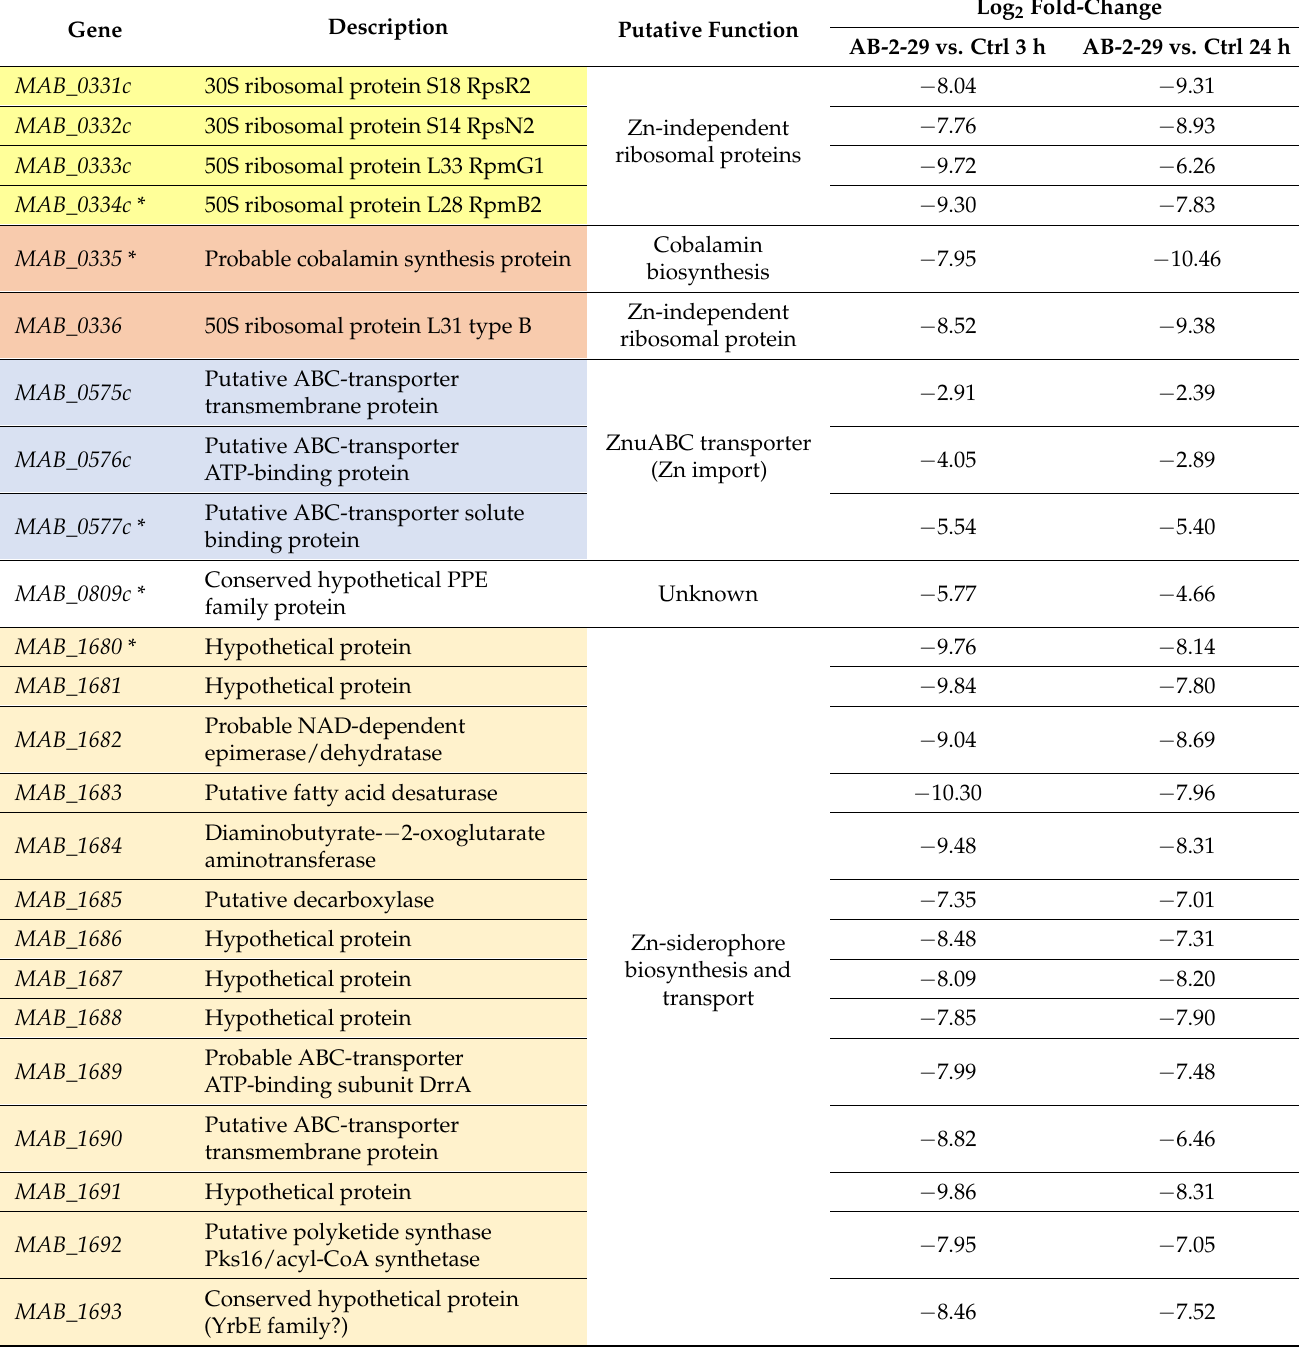
Table 2. List of Zur regulon genes that were expressed at higher or lower levels upon treatment with AB-2-29 compared to DMSO control . Differentially expressed genes upon treatment with 20 µ M AB-2-29 for 3 or 24 h were defined as ≥ 2 log 2 fold-change in expression compared to cells treated with 0.2% DMSO for the same amount of time, with a false discovery rate adjusted p -value (padj) < 0.05. Genes harboring a zur-box in their promoter (see Figure 2B) are marked with an asterisk. Similarly colored genes denote gene clusters likely to be cotranscribed. MAB_0331c, MAB_0332c, MAB_0333c, MAB_0334c and MAB_0336 are Zn-independent alternative ribosomal proteins. MAB_0335 is likely to be involved in cobalamin biosynthesis. MAB_0575c-MAB_0576c- MAB_0577c encode a putative zinc importer of the ABC-transporter family. The operon encompassing genes MAB_1680 to MAB_1701 encodes putative Zn-siderophore biosynthesis and transport proteins, including a putative ABC-transporter and an MCE family